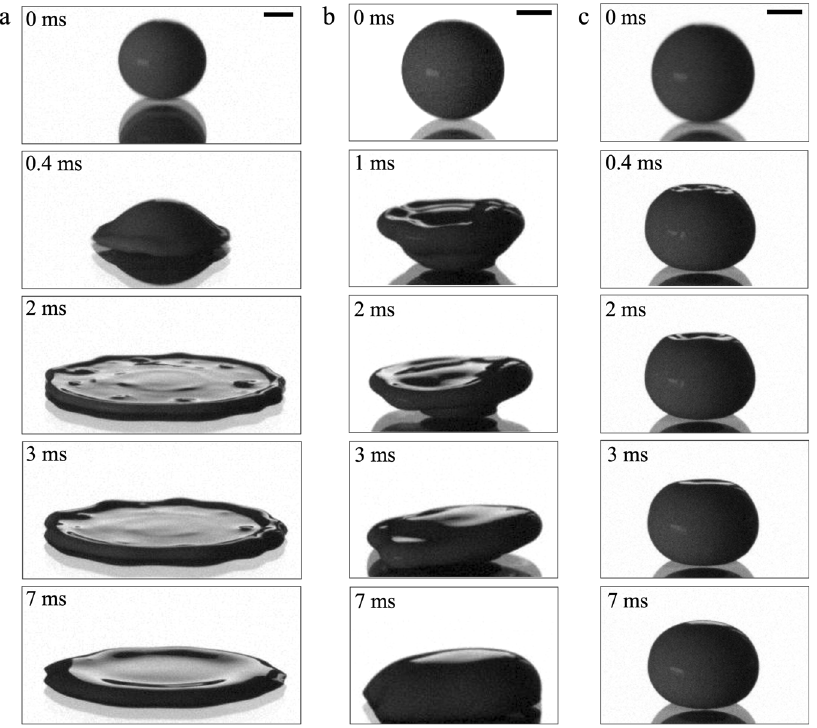
Fig. 2 Exotic impact behaviours of colloidal suspension drops. a Timeseries of a ϕ = 0.47 colloidal drop expanding after impacting at u 0 = 3.0 m/s [Video SI1 27 ]. The spreading drop shows transient pockets of localized solidi fi cation, indicating the onset of shear thickening. b Timeseries of a ϕ = 0.49 colloidal drop impacting at u 0 = 2.0 m/s [see also Video SI2]. The bottom half of the drop solidi fi es, while the still- fl uid top portion fl ows over it. c Timeseries of a ϕ = 0.49 drop impacting at u = 3.0 m/s [Video SI3 27 ]. While most of the drop is solidi fi ed, the top portion of the drop is in the liquid phase. All scale bars 0 are 1 appears (orange diamonds), followed by the bulk solidi fi cation regime (blue triangles), where a larger and larger portion of the drop solidi fi es upon impact. The transition between these regimes is a function of both ϕ and u 0 , as all regimes can be accessed by varying either of the parameters while keeping the other constant.